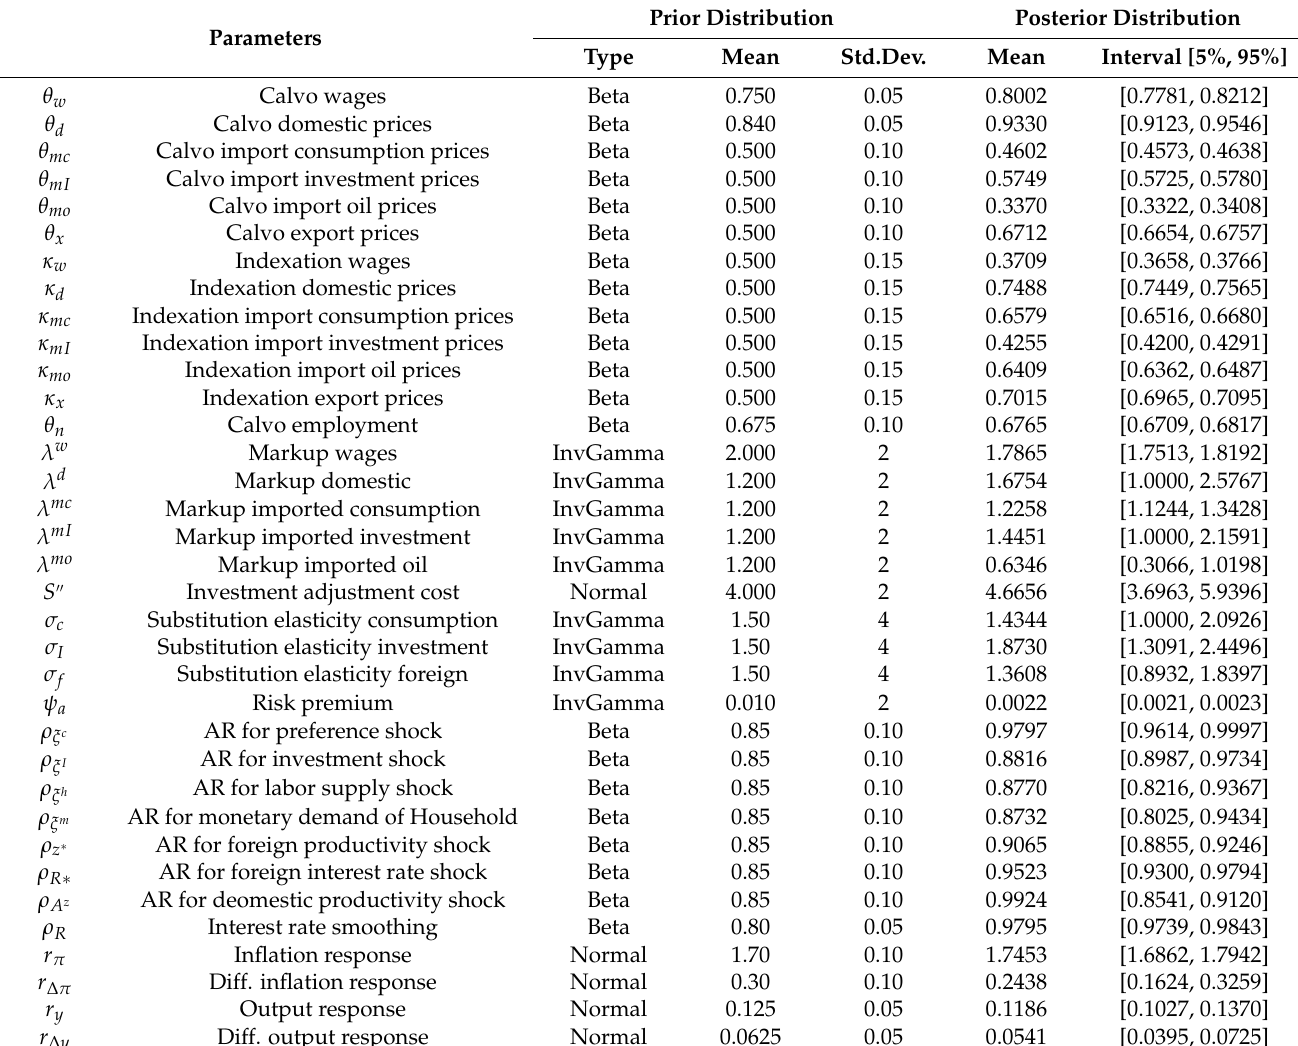
Table 3. Prior distribution and Bayesian estimation